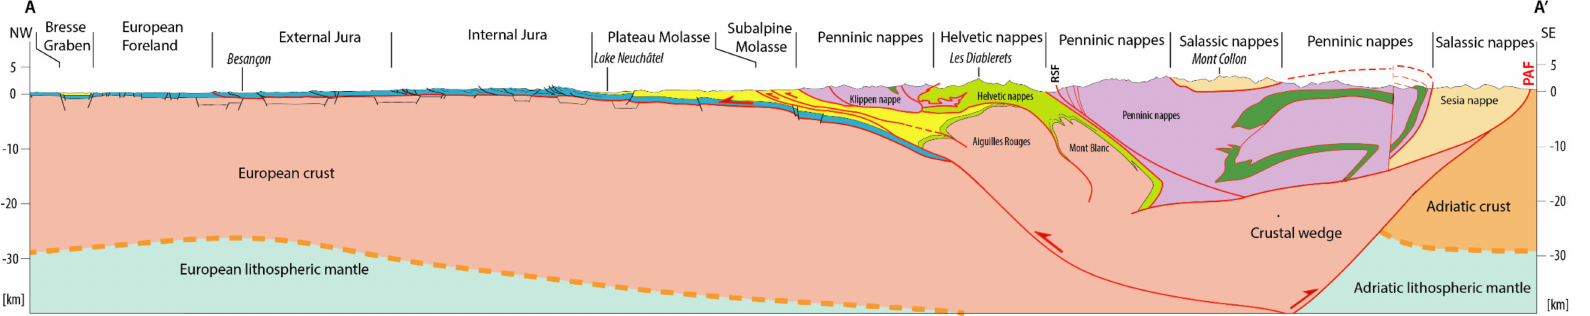
Figure 3. Cross section (SE-NW) through the Alps from the Po Basin to the Bresse graben (see Figure 2 for the section line). PAF: Peri-Adriatic fault